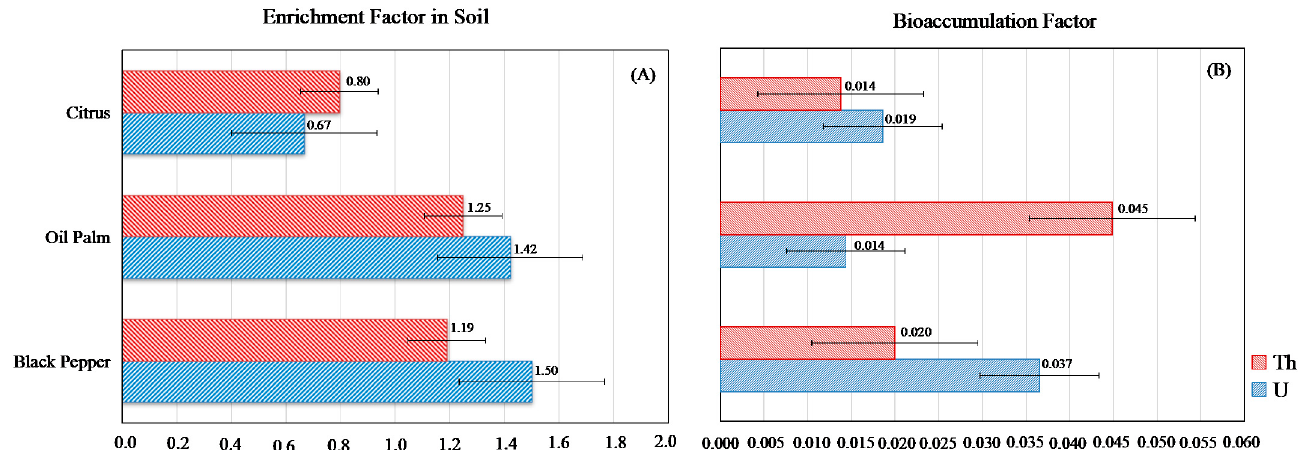
Figure 4. Enrichment ( A ) and bioaccumulation ( B ) factors of uranium and thorium in the cultivated soils and plants. The average concentrations of U and Th in plant tissues were, respectively, 0.08 and 0.18 mg kg − 1 for citrus, 0.05 and 0.48 mg kg − 1 for black pepper and 0.04 and 0.10 mg kg − 1 for oil palm (Figure 2, Table S1). The bioaccumulation factors of U and Th for the three crops were extremely low, with BAF values < 0.05 (Figure 4B). In soils, with the exception of the citrus soil, all the areas showed higher activity concentrations of 238 U and 232 Th compared to the reference areas (Table 2). The activity concentration of 232 Th in the tissue of black pepper was extremely high (1948.8 mBq kg − 1 ) (Table 3). The activity concentrations of the radioelements in the plant tissues followed the orders: 238 U (mBg Table 2. Activity concentrations of uranium and thorium in soils ( n = number of samples).